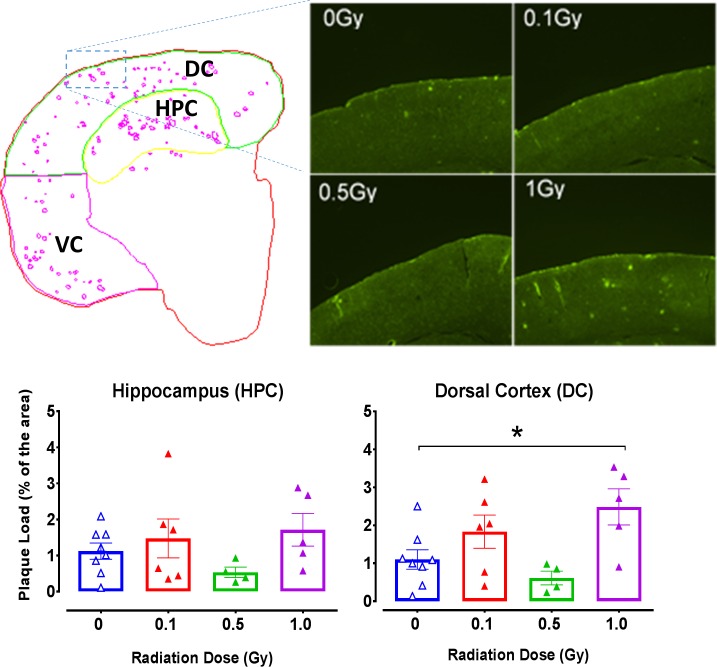
IHC analyses of Aβ deposits in TG mice 9 months post-irradiation.Top left panel: A representative illustration of a medial coronal section of the brain of a TG mouse divided into 3 areas of interest: hippocampus (HPC, dorsal cortex (DC) and ventral cortex (VC). The purple spots indicate the software’s built-in algorithm detection of amyloid plaques that was further visually confirmed by the experimenter. Top right panel: Original micrographs of cortical sections exposed to 0–1 Gy. Bottom panels: Relative numbers of plaque areas measured in the hippocampus and the dorsal cortex. Significant differences in Aβ deposition were detected between 0 vs 1 Gy groups in the DC and similar trends were observed in the HPC. TG mice only: N = 8, 7, 4 and 5 animals/radiation group. Statistical analyses: 1-way ANOVA, Post hoc * p<0.05. Data represent means ± SEM.